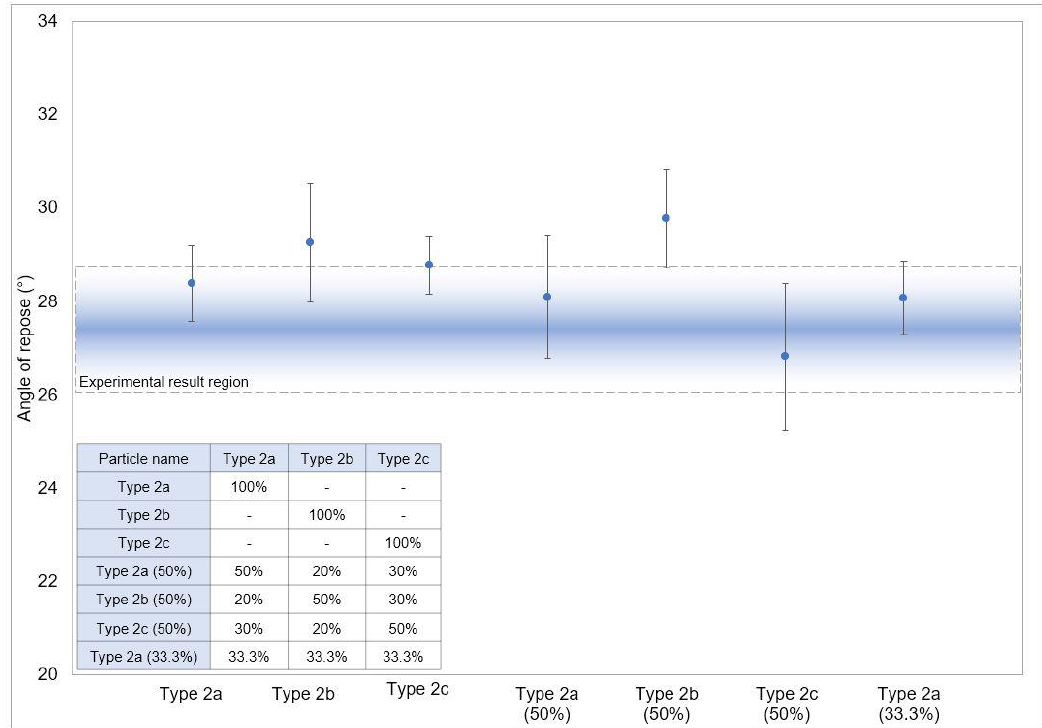
Figure 14. Angle of repose for different percentages of powder morphologies (Type 2a – c) in simu- lation powder pool.